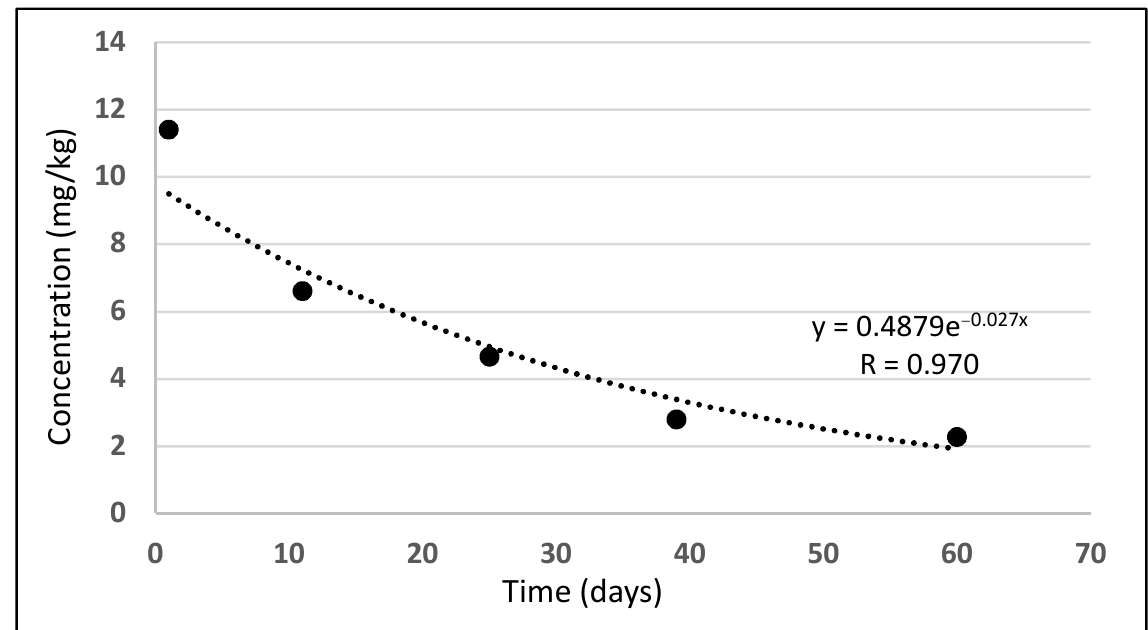
Figure 2. Diflufenican dissipation in the soil. Table 1 presents percentage degradation of diflufenican after 11, 25, 39, and 60 days from the application of EmFarma Plus™, Rewital PRO+, and BACILLUS VIP Probiotic Microorganisms versus the control.